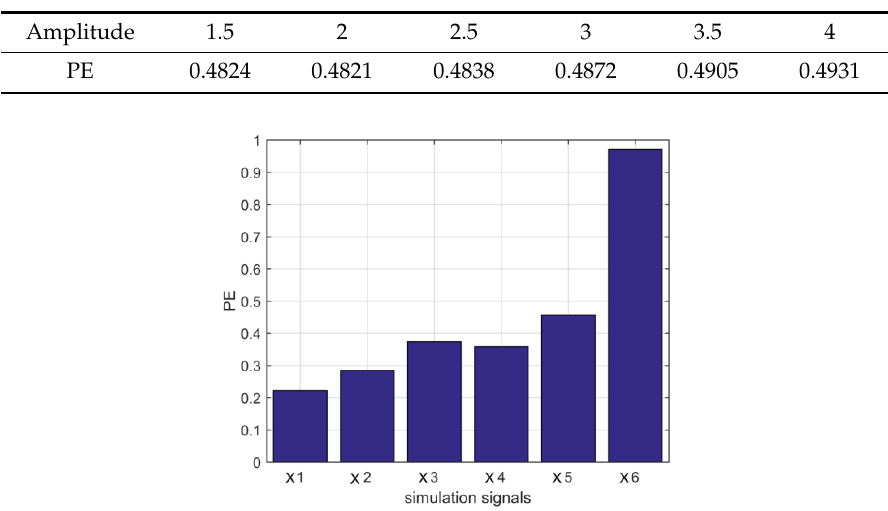
Table 2. The permutation entropy values corresponding to different frequency of modulation signal.